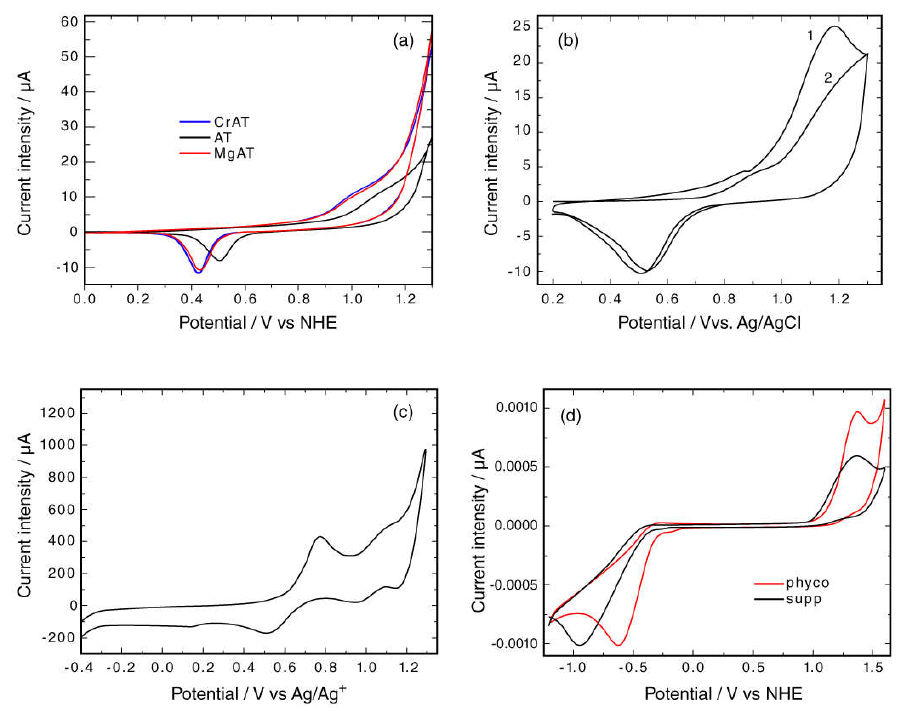
Figure 4. Voltametric profiles recorded for different electrodes/solution systems. ( a ) For Au- pc in a delphinidin-3-glucoside-containing solution in the supporting electrolyte (black line); for Cr (III) (blue line) and Mg (II) (red line) metal complexes. Measured at v = 0.01 V s − 1 . ( b ) For Au- pc in xanthophylls containing solution in the supporting electrolyte, at v = 0.05 V s − 1 . Reference electrode Ag/AgCl (0.195 V vs. NHE). ( c ) For Au- pc in a violacein-containing solution in the supporting electrolyte, at v = 0.05 V s −1 . The potential of the reference electrode Ag/Ag + = 0.48 V vs. NHE. ( d ) For FTO electrodes in a phycocyanin-containing solution in the supporting electrolyte, at v = 0.01 V s −1 .